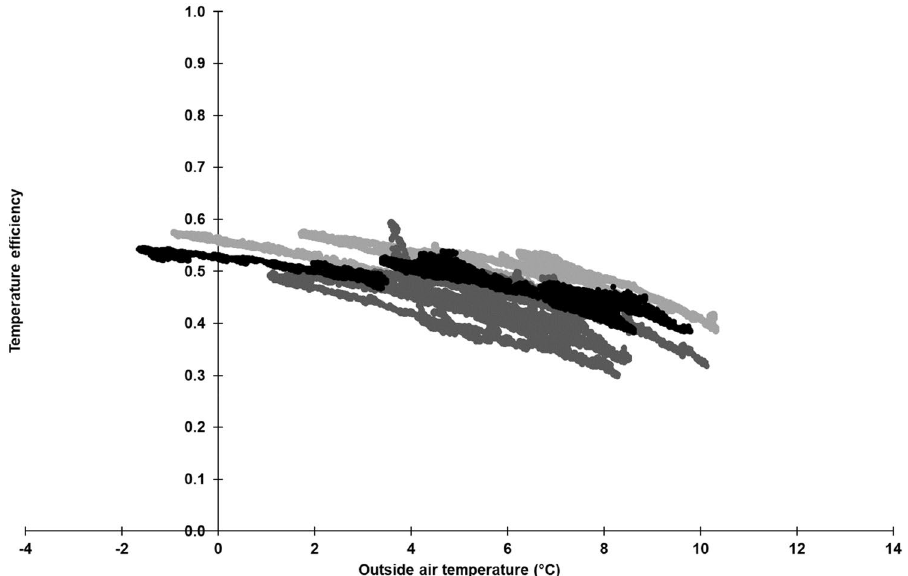
Figure 5. Temperature efficiency of the heat exchanger scrubber pilot-plant dependent on outside air temperature at an air flow rate of 1000 m 3 h −1 . Light grey dots: assembly situation A; dark grey dots: assembly situation B; black dots: assembly situation C; n = 20,400 per each experimental